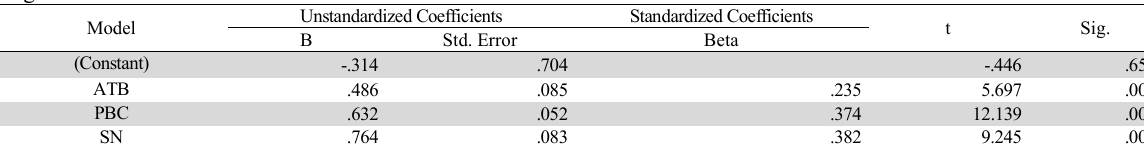
Regression Result Unstandardized Coefficients Standardized Model